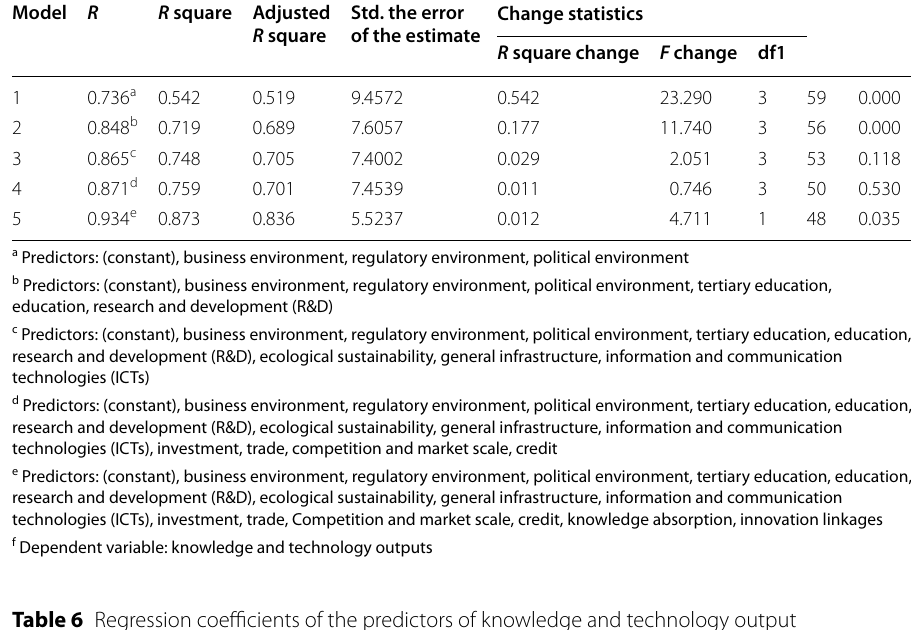
Table 6 Regression coefficients of the predictors of knowledge and technology output